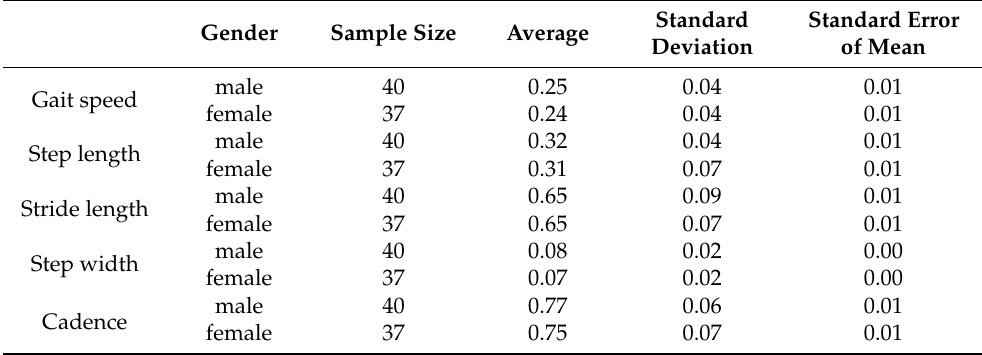
Table 6. Gait factor after standardization (dimensionless numbering coefficients for normalization of gait